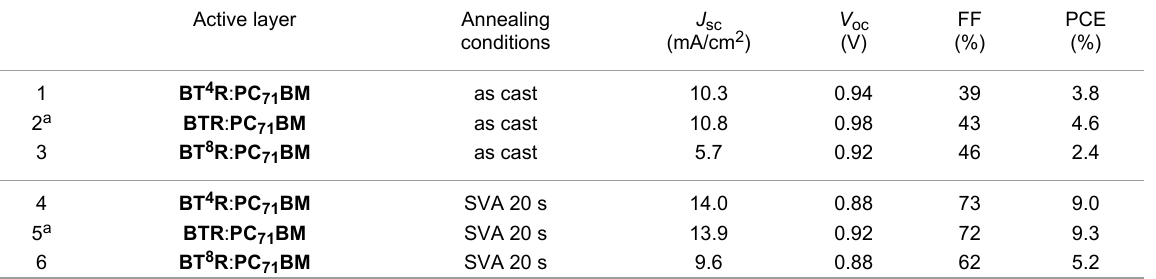
Table 5: Photovoltaic performances of BT X R:PC 71 BM BHJ solar cells fabricated under different annealing conditions.